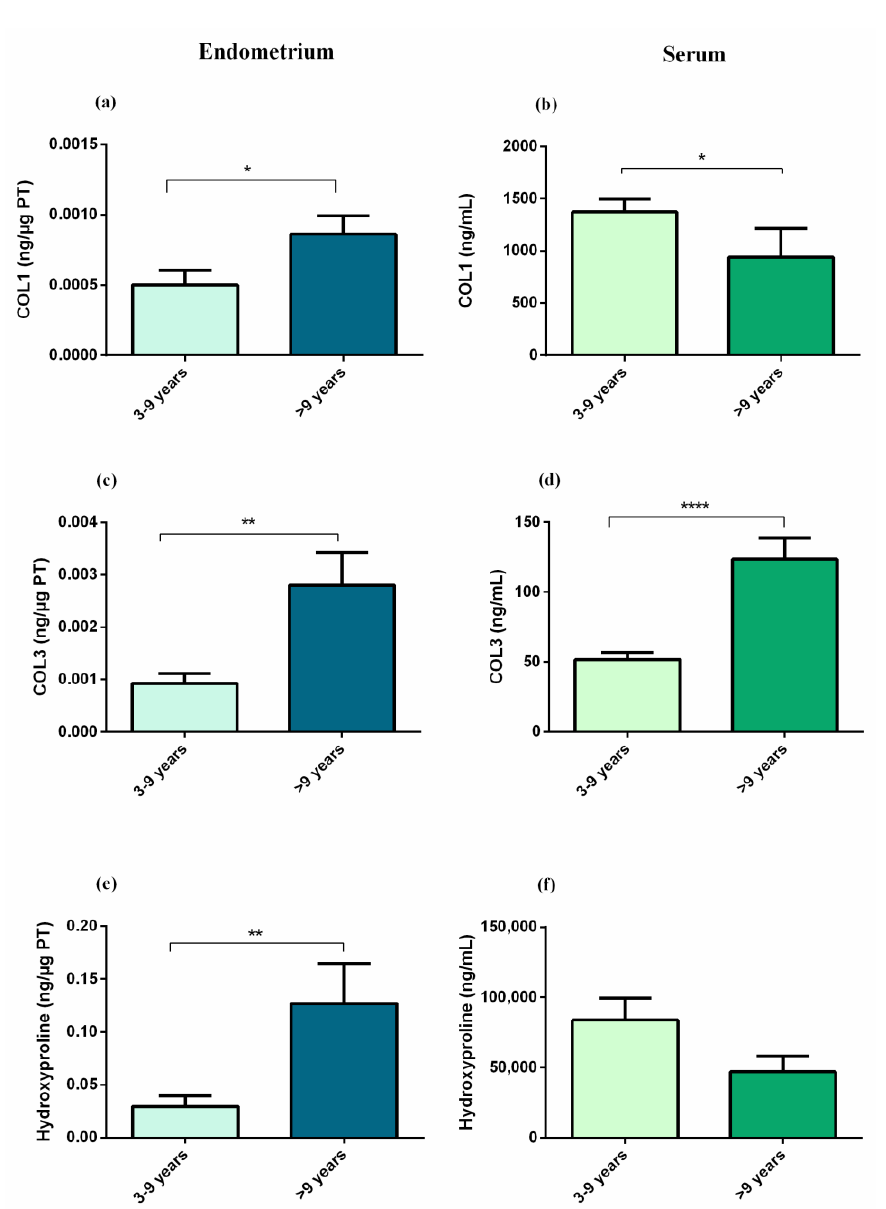
Figure 3. Effect of mares age (3 to 9 years old vs. over 9 years old) on the concentrations of ( a ) type I collagen (COL1) in endometrial tissue, ( b ) COL1 in serum, ( c ) type III collagen (COL3) in endometrial tissue, ( d ) COL3 in serum, ( e ) hydroxyproline in endometrial tissue, and ( f ) hydroxyproline in serum. Bars represent mean ± SEM. Asterisks indicate significant differences between age groups (* p < 0.05; ** p < 0.01; **** p < 0.0001).